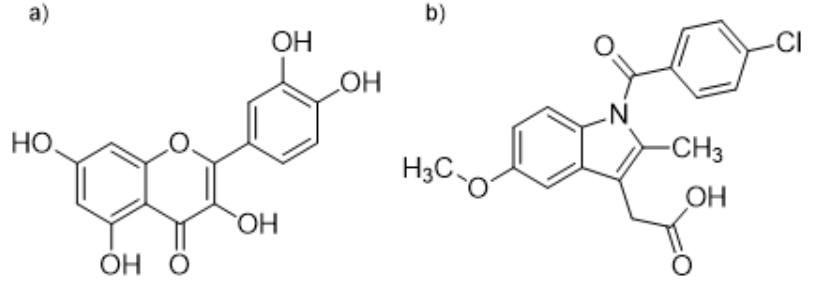
Figure 1. Structural formulas of ( a ) quercetin (QUE) and ( b ) indomethacin (IND).